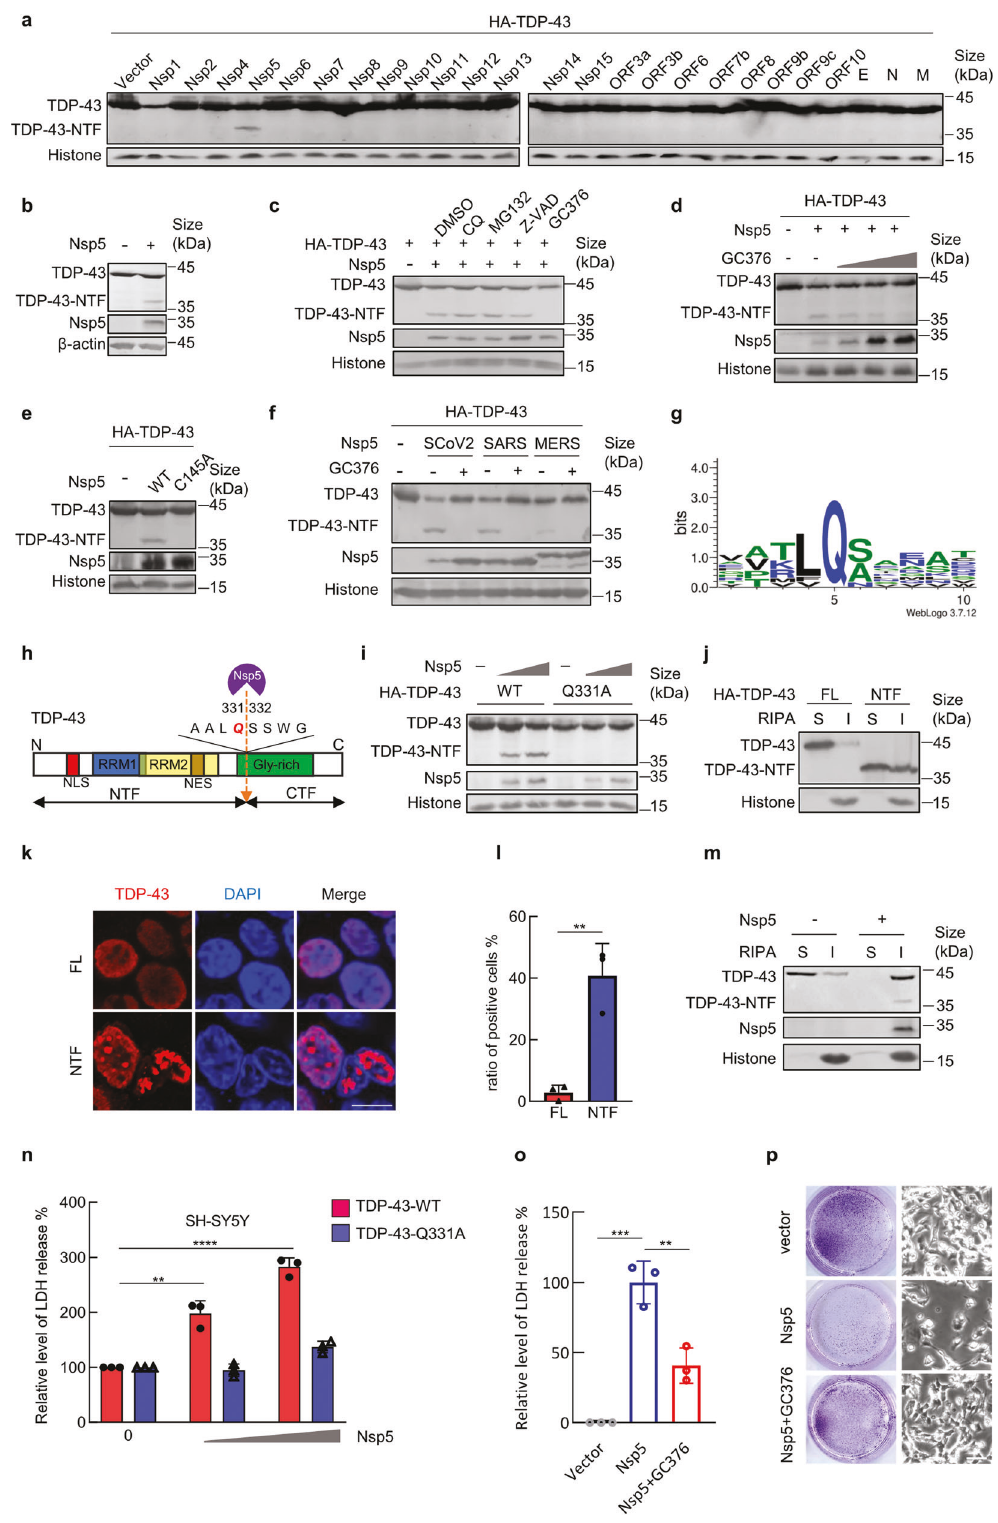
supporting the ability of Nsp5 to cause neural damage Nsp5 via cleavage of TDP-43. The observed dependence of 3CLpro activity on Nsp5-mediated TDP-43 cleavage led us to measure the effects of the